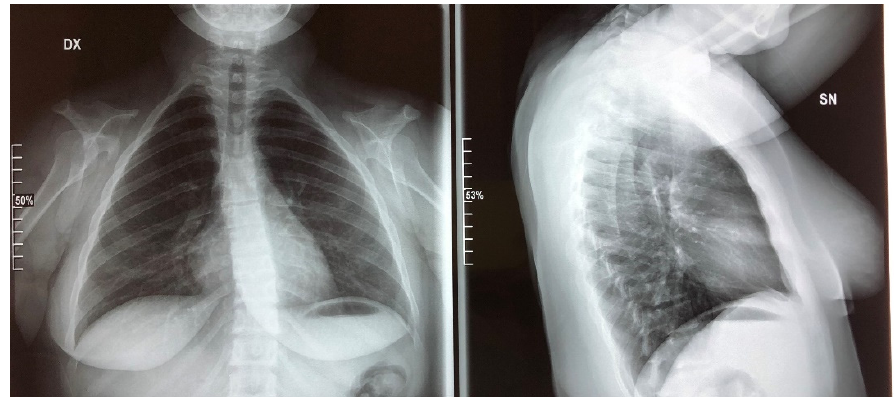
Medicina 2021 , 57 , x FOR PEER REVIEW Figure 11. Thorax X-ray in 2021 showing a narrow and bell shape thorax. Figure 11. Thorax X-ray in 2021 showing a narrow and bell shape thorax.